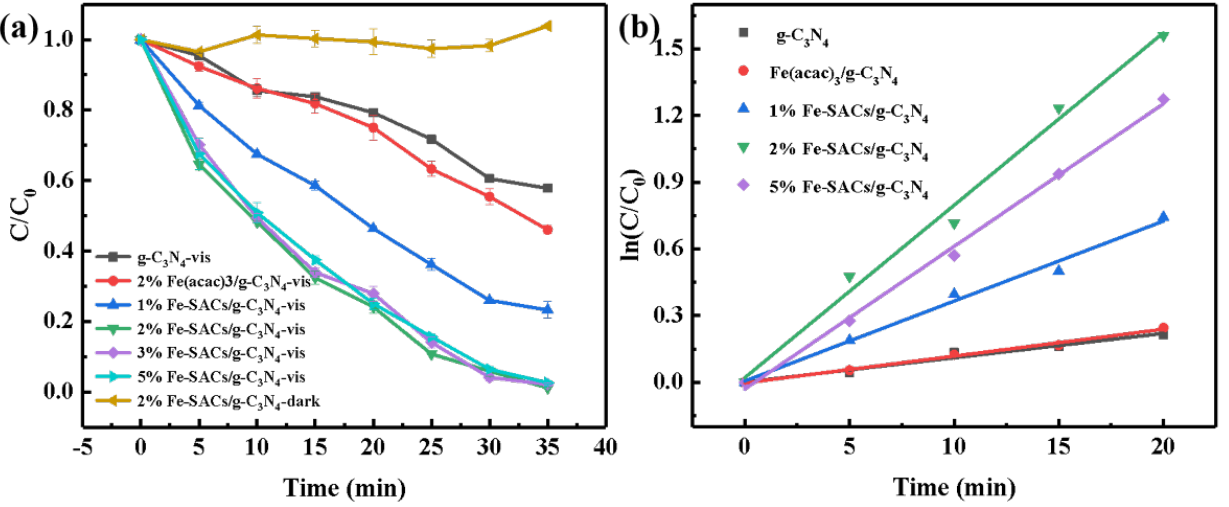
Figure 7. ( a ) Photocatalytic MBT removal ratio by various photocatalysts; ( b ) Pseudo-first-order kinetics over materials.